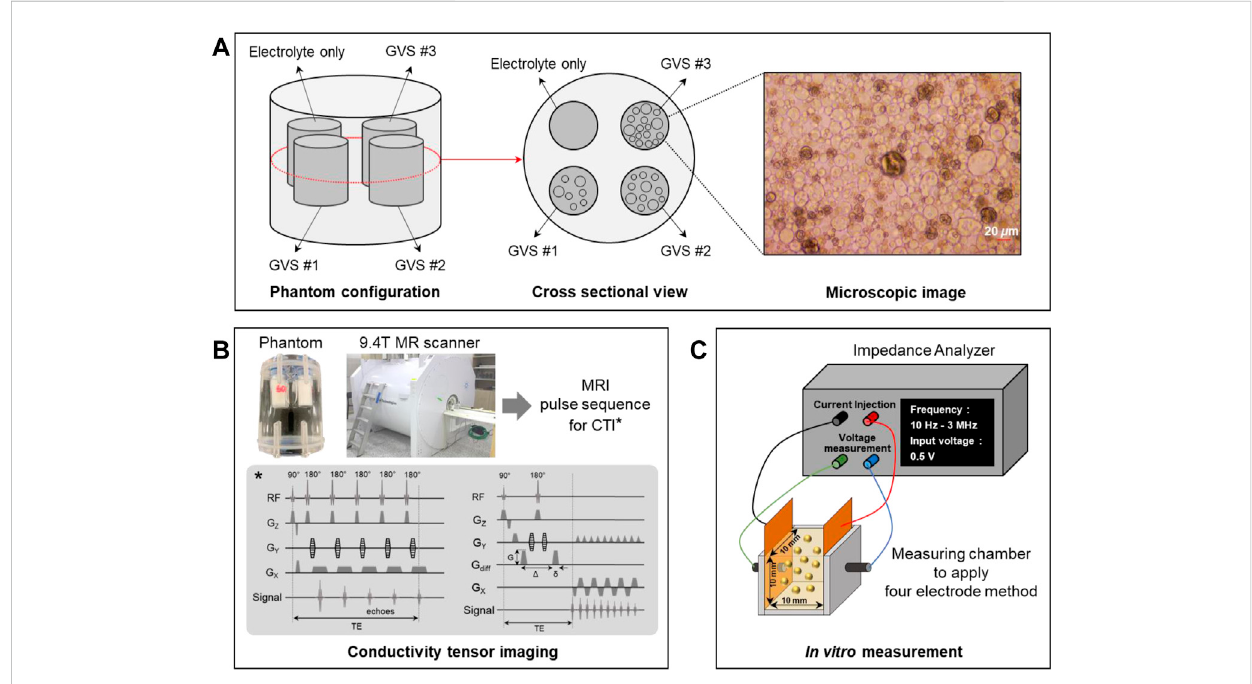
FIGURE 1 Phantom preparation (A) , experimental setup for CTI experiment using a 9.4T MRI scanner (B) , and in vitro measurement of conductivity spectra using an impedance analyzer (C)